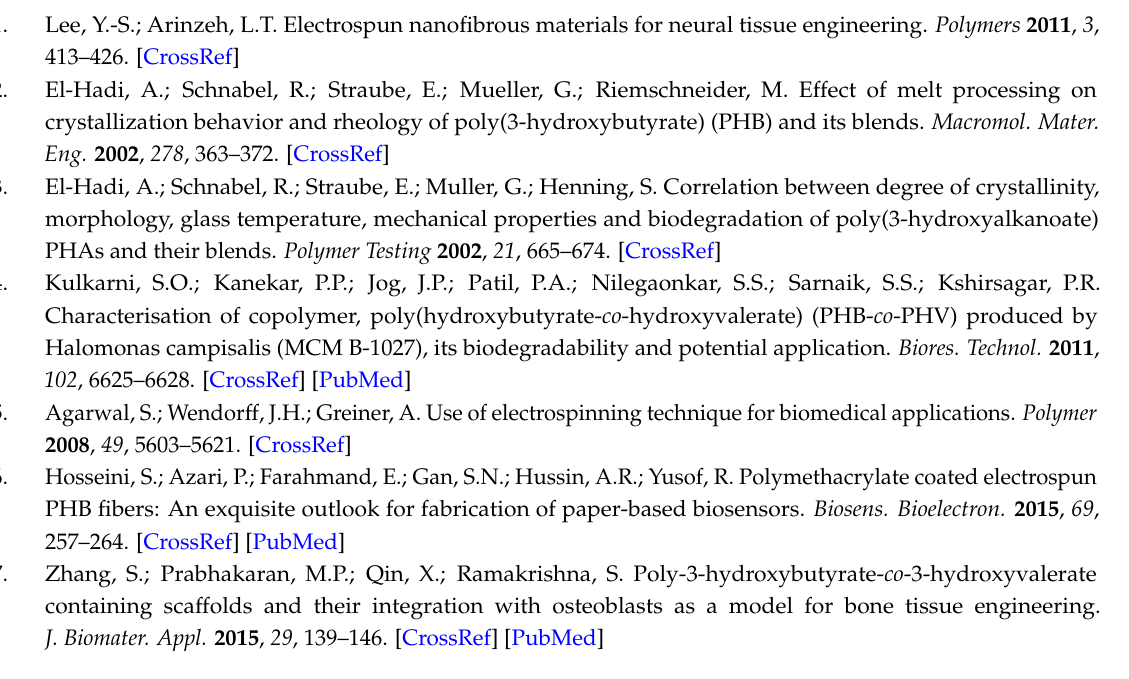
Figure S1: Electrospinning on the rotating drum in our lab (homemade); Figure S2: Electrospinning at a fixed target to obtain random fibers; Figure S3: Fiber rolling after electrospinning processes on the frame and the method to collects by the frame for the dumb bell